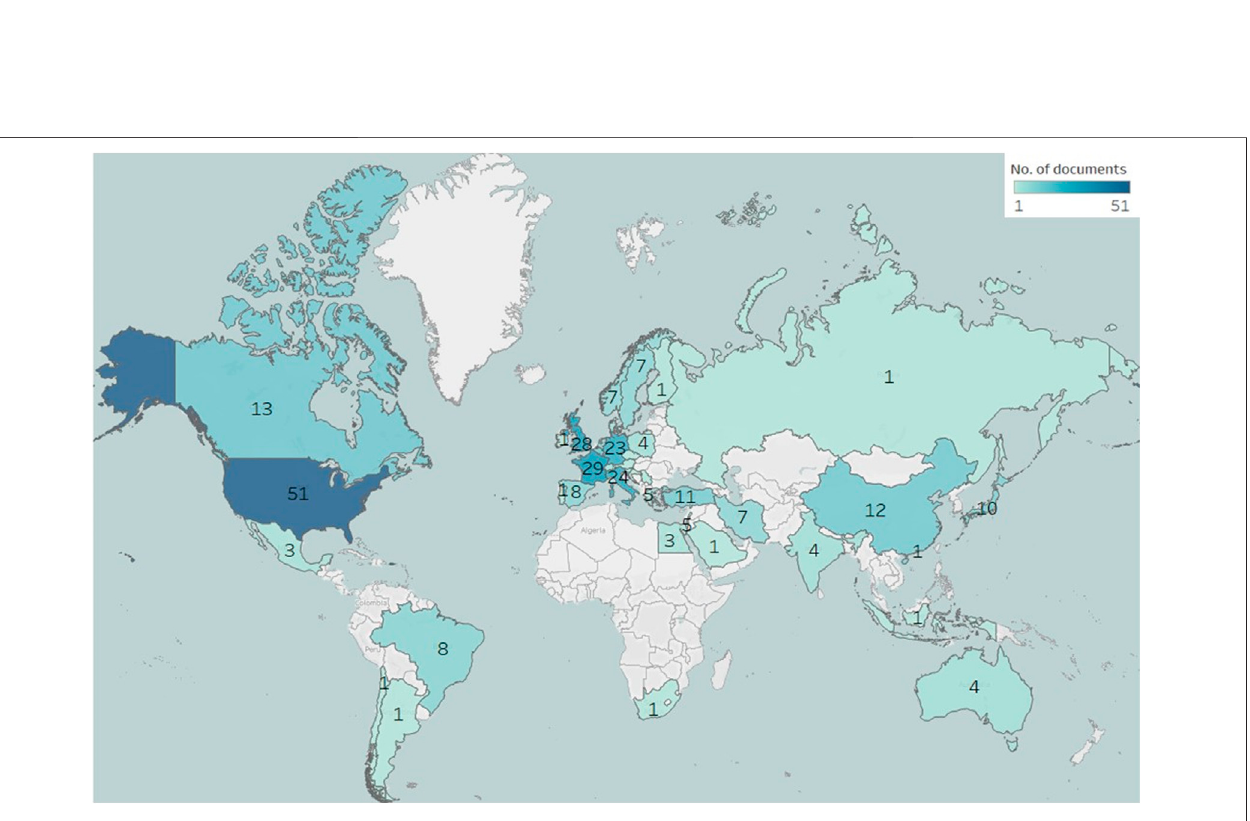
TABLE 1 | Top fi ve institutions contributing to the fi eld of research related to radiotherapy and its impact on male fertility. Institutions (Rank) Number of Publications Percentage of Total